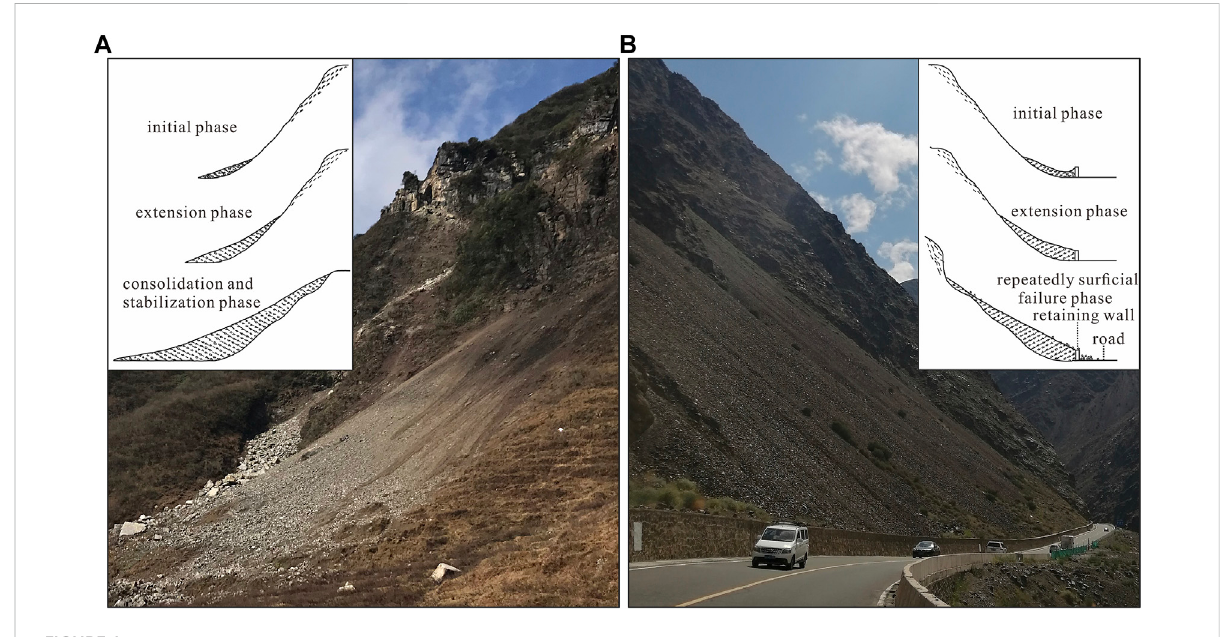
FIGURE 1 Natural granular slope (A) and granular slope con fi ned by the retaining wall (B)